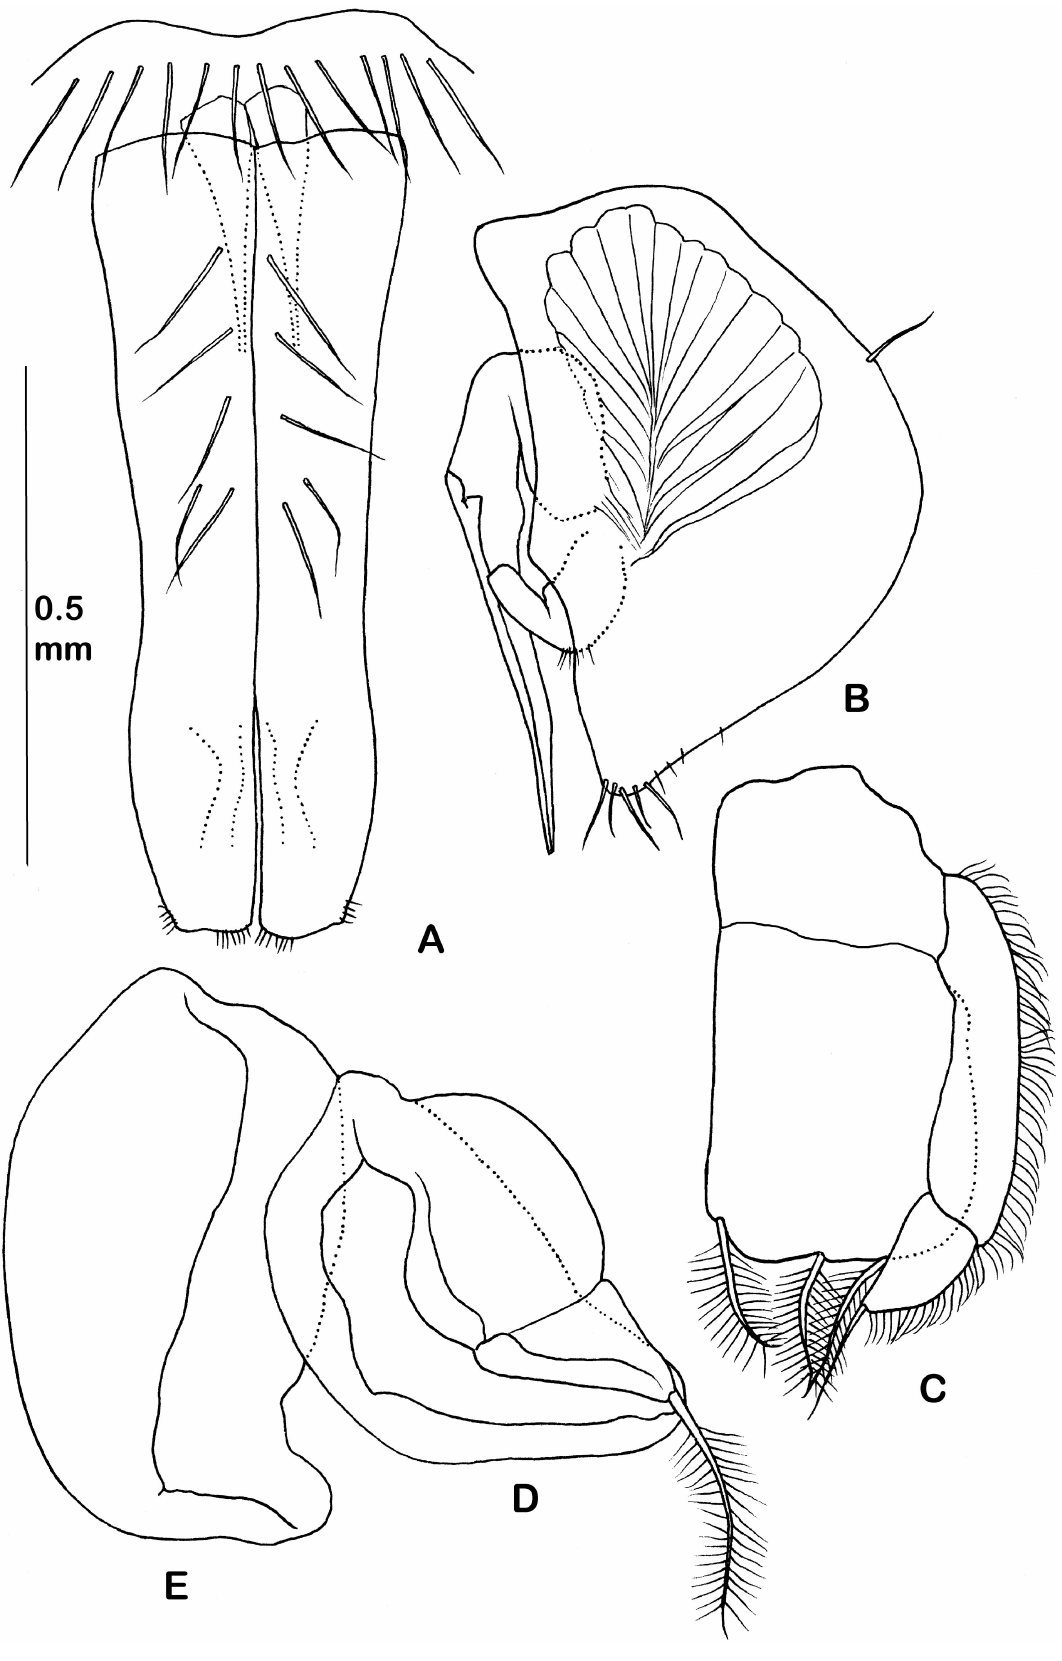
Figure 16. Eurycope mishkai sp. nov. Male paratype (ZMH K-45624): ( A ) pleopod I; ( B ) pleopod II; ( C ) pleopod III; ( D ) pleopod IV; ( E ) pleopod